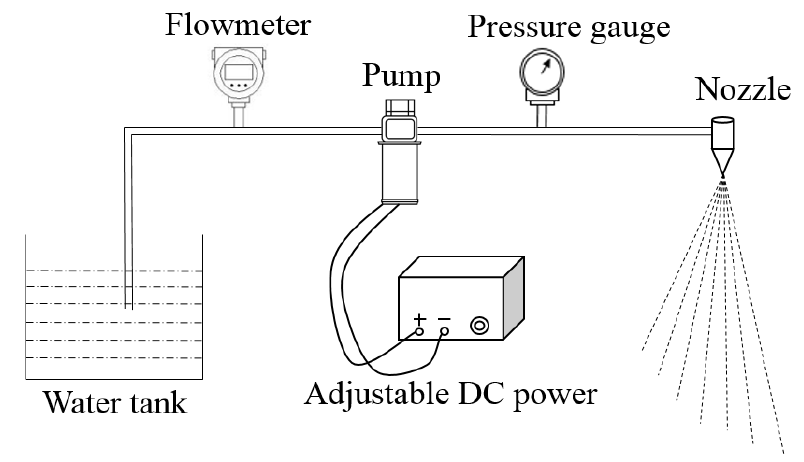
Figure 3. Spray test system.